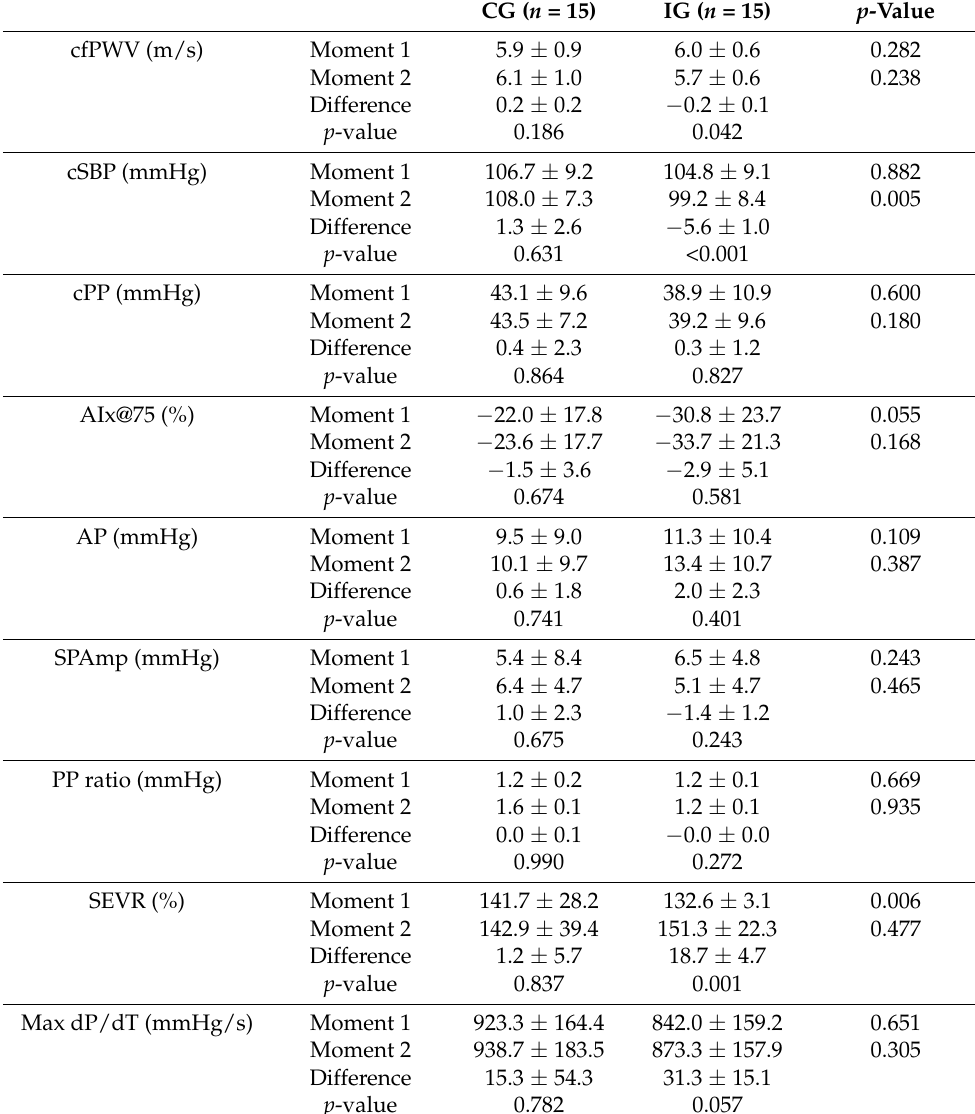
Table 4. Difference between the control group and the intervention group in the 2 assessment moments in the central hemodynamic